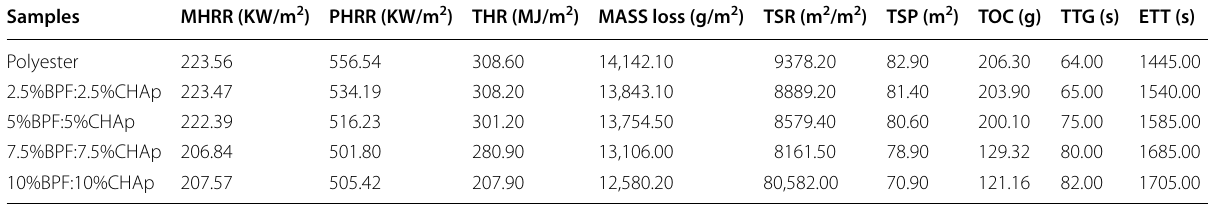
Table 2 Fire properties of developed composites of polyester with BPF and CHAp Samples